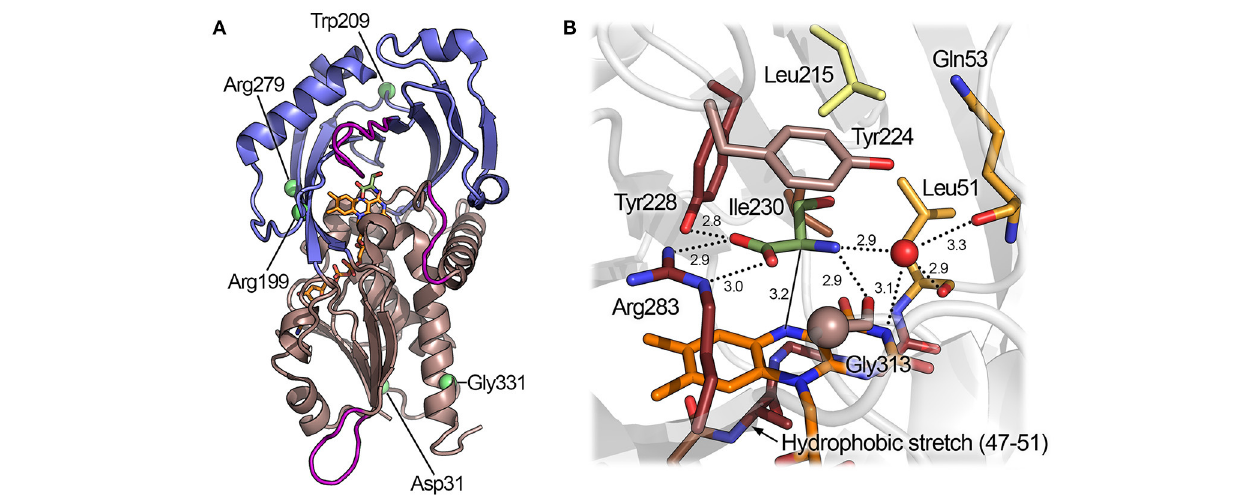
FIGURE 5 | Three-dimensional structure of hDAAO. (A) Schematic view of the spatial arrangement of protein domains in hDAAO (PDB code 2e49) (Kawazoe et al., 2007b). The FAD binding domain is in dark salmon color and the substrate binding domain is in blue. Regions showing the highest conformational diversity are in purple; α -helices, β -strands, and coils are drawn in cartoon representation. (B) Detail of the active site. The substrate D-Ser was modeled based on the structure of the enzyme in complex with imino-serine. Residues are colored according to their ConSurf score from darker (most conserved) to lighter (less conserved) color. Gly313 α C is represented as a sphere. The “putative” active-site water molecule is in red (see text). The FAD cofactor (orange) and the ligand (green) are shown in stick form. The H-bonds are represented by dotted lines while the distance between the α -H of the substrate and the N(5) of FAD is depicted with a continuous